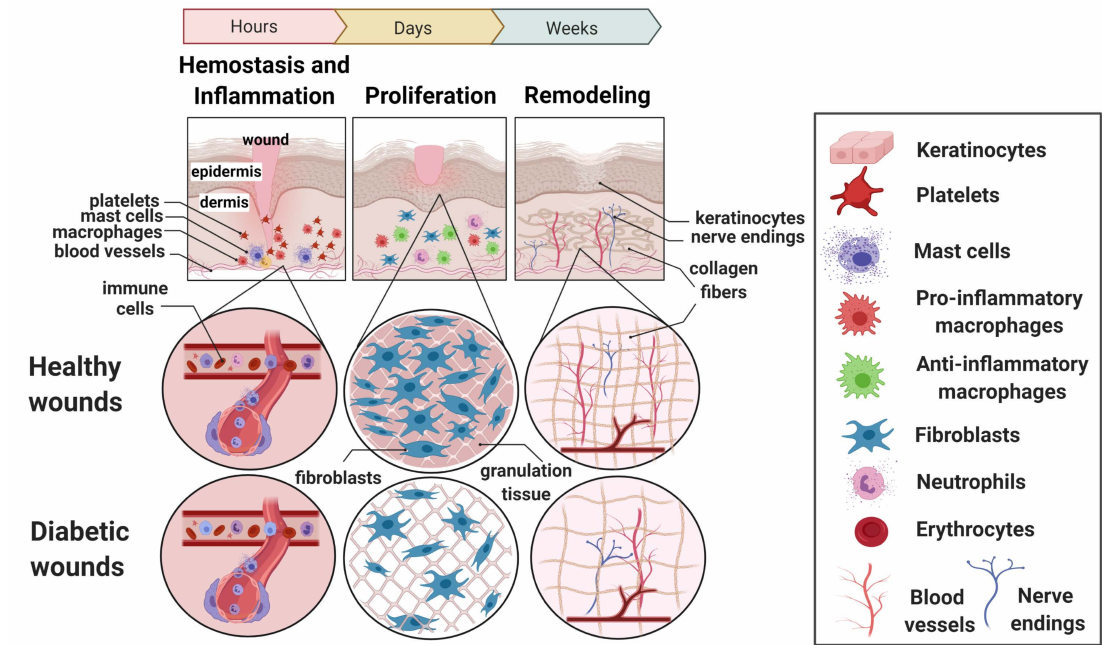
Figure 1. Three main stages of normal and diabetic wound healing. Also shown are the predominant skin cells involved at each stage of the process. Wound healing in healthy and diabetic skin is similar in the order of and key events occurring throughout the three overlapping phases. However, it di ff ers significantly in the length and progression of the inflammatory phase under diabetic conditions, making the wounds fail through progression towards successful